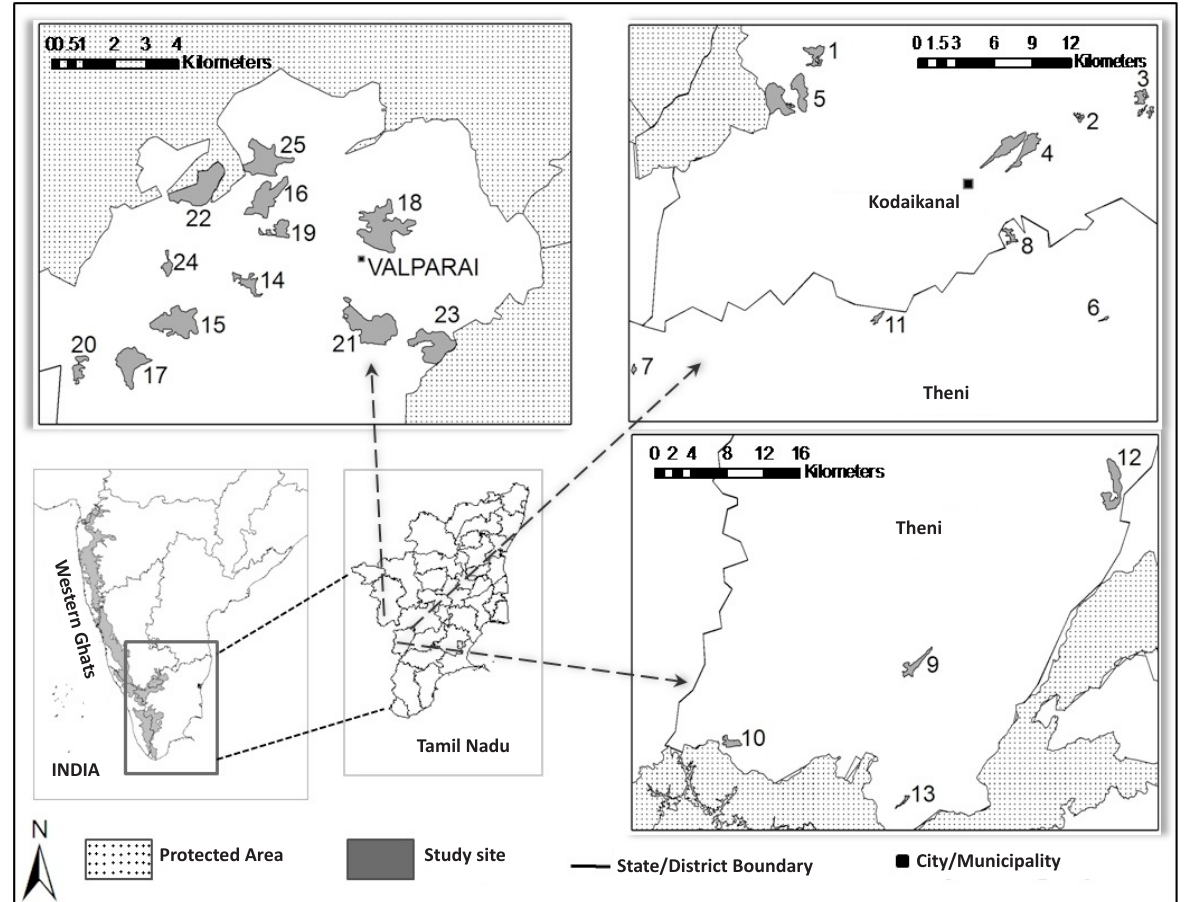
Figure 1. Map of the study sites at Valparai, Kodaikanal and Theni and their location within the state of Tamil Nadu in southern India. Refer to Site No. in Appendix 1 for the identity of study-sites. Study-sites were digitized using LISS III data and shape files obtained from the local collaborator, Conservation Research Group, St. Albert’s College, Kochi and VdS Technologies